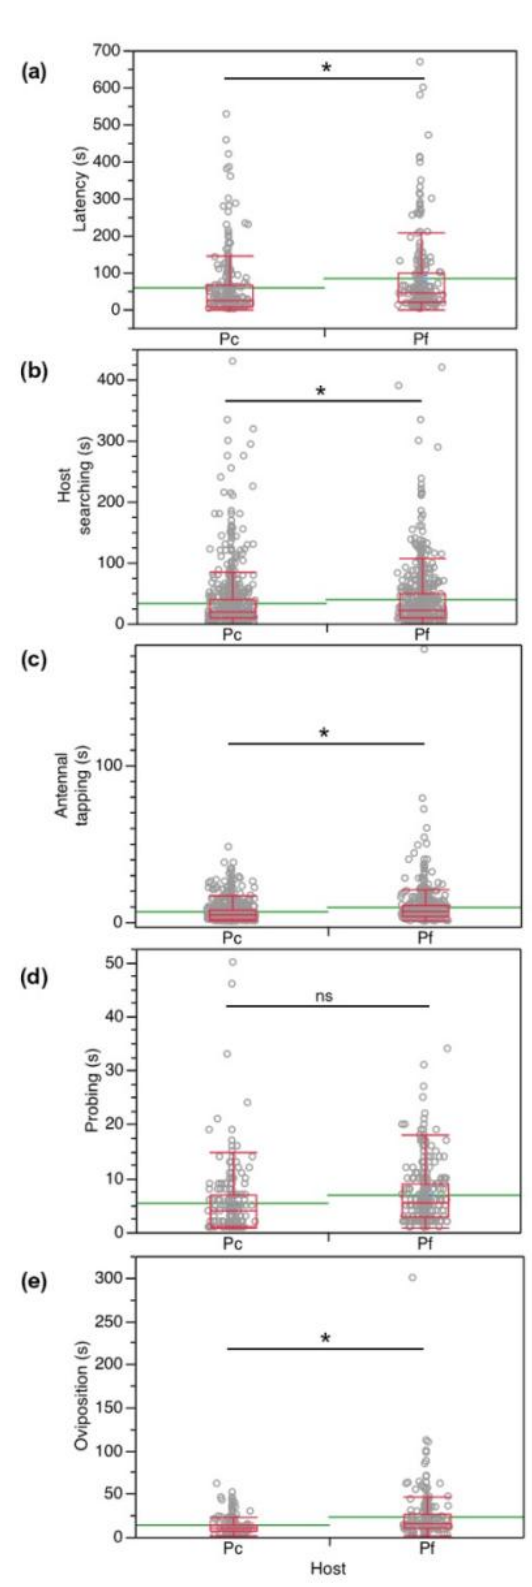
Figure 4. Time spent by Anagyrus vladimiri during ( a ) latency, ( b ) host searching, ( c ) antennal tapping, ( d ) probing, and ( e ) oviposition displays in no-choice tests carried out on Pseudococcus comstocki (Pc) and Planococcus ficus (Pf). Each box plot indicates the median (central line) and its range of dispersion (lower and upper quartiles and outliers); green lines indicate the means. Asterisks indicate significant differences (GLM, p < 0.05); ns = not significant. The frequency of behavioral displays performed by A . vladimiri approaching its host in no-choice tests highlighted some differences about host searching ( χ 2 = 11.17, d.f. = 1, p = 0.0008), encounter ( χ 2 = 6.31, d.f. = 1, p = 0.012), antennal tapping ( χ 2 = 4.38, d.f. = 1, p = 0.0362), probing ( χ 2 = 12.4, d.f. = 1, p = 0.0004), oviposition ( χ 2 = 9.95, d.f. = 1, p = 0.0016) and